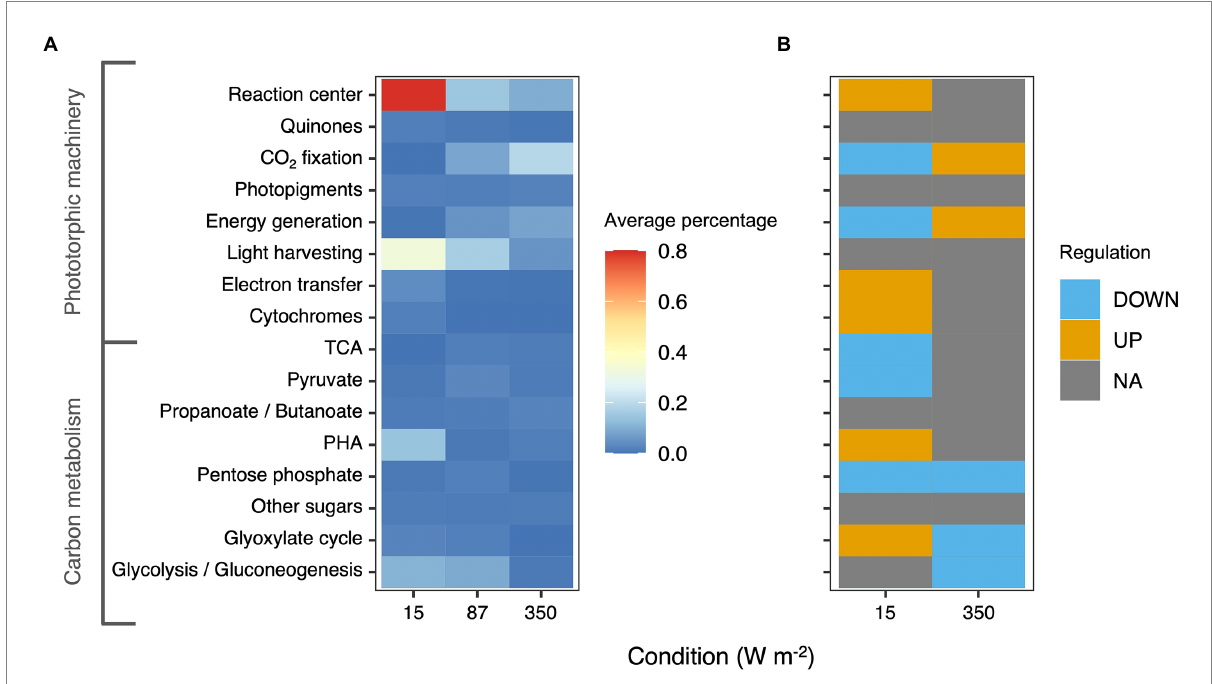
FIGURE 5 (A) Heatmap representing the average percentage of the protein expressed in each metabolic category based on KEGG classification. The heatmaps represents only carbon metabolism and phototrophic pathways. (B) Differential regulation of the different pathways under 15 and 350 W m − 2 compared to the 87 W m − 2 condition. Oxidative phosphorylation and photosynthesis pathways were upregulated in the 350 W m − 2 condition and downregulated in the 15 W m − 2 conditions compared to the 87 W m − 2